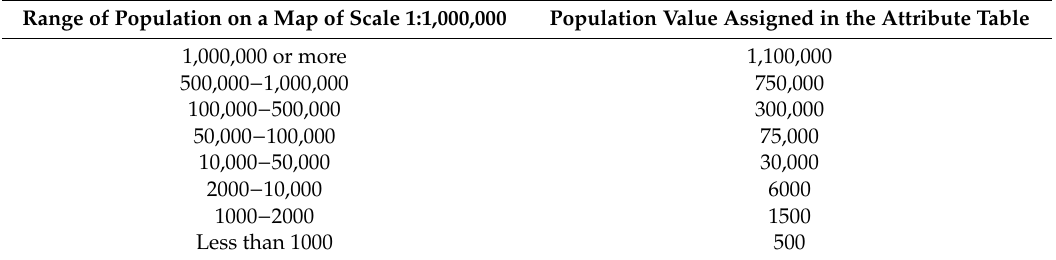
Table 1. Recalculation of population to estimate density.